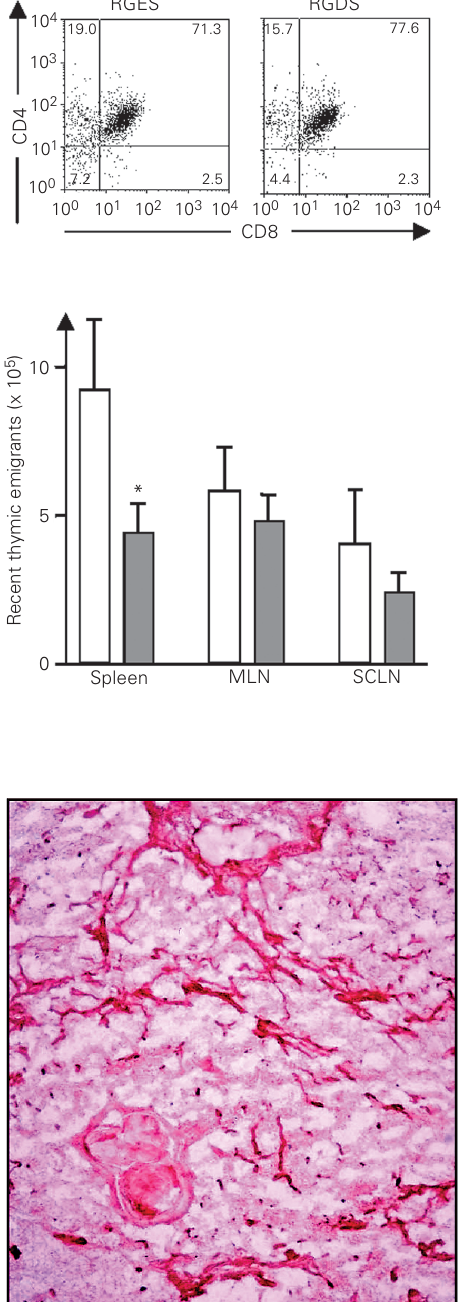
250X.Figure 8. RGD-containing pep- tide modulates recent